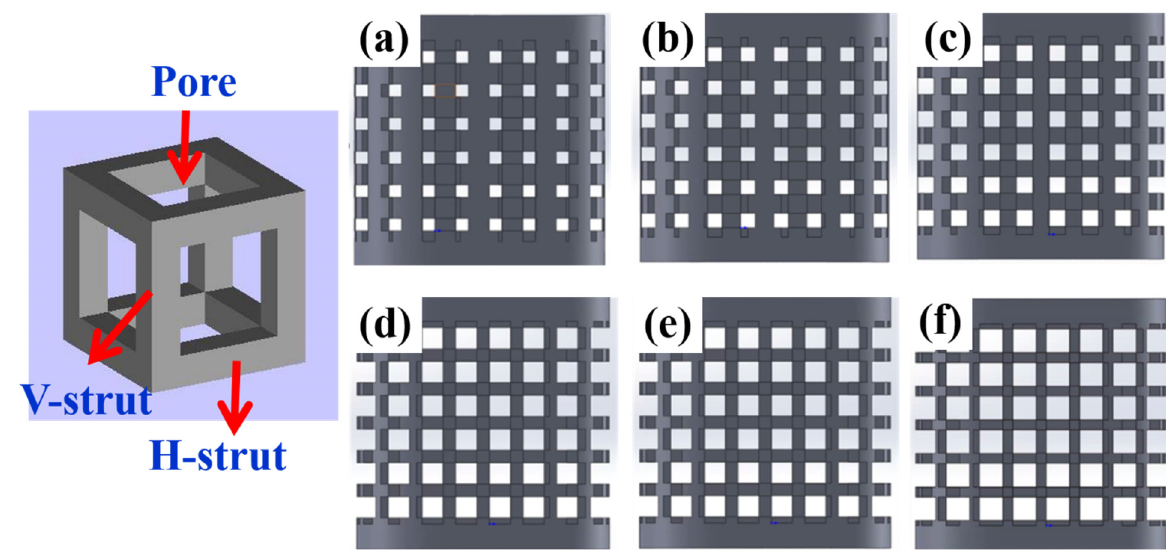
Figure 1. Schematic diagram for cubic unit cell pore and strut morphologies with side view of the designed Ti6Al4V porous structures from ( a – f ). Long axis of the vertical struts denotes that the V-strut was parallel to the compressive force direction, while the horizontal ones denote that the H-strut was vertical to the direction of the force. Specimens with different porosities based on the strut size change from 25% to 63% in porosity are shown: ( a ) 25%, ( b ) 33%, ( c ) 40%, ( d ) 55%, ( e ) 59%, and ( f ) 63%.